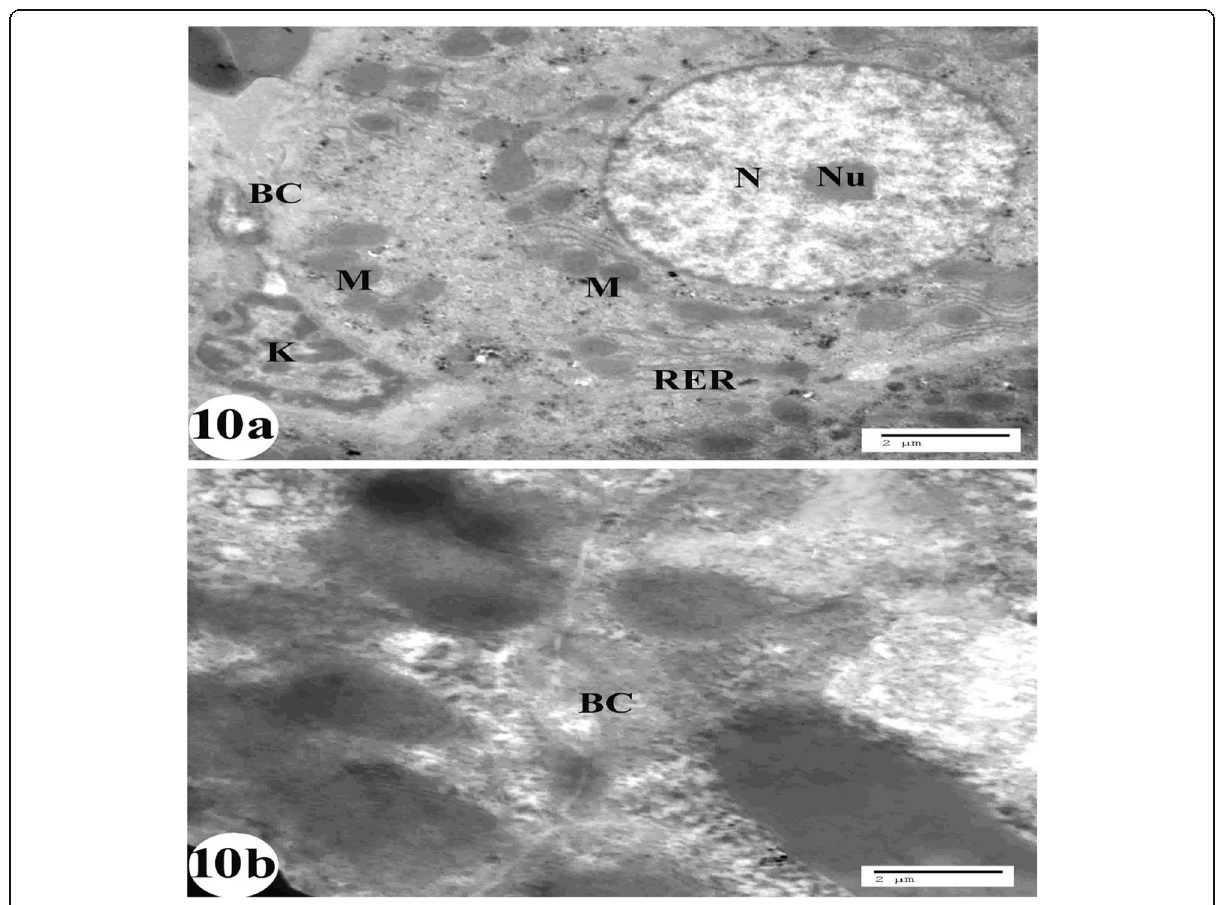
Fig. 10 Electron micrographs of a sections of liver of a control rats a showing hepatocytes contains numerous mitochondria (M), rough endoplasmic reticulum (RER) consists of closely pack parallel and flattened cisternae, spherical nucleus (N) appears with a distinct nuclear envelope and prominent nucleoli (Nu), Kupffer cell (K) with normal nucleus and normal bile canaliculi (BC) (scale bar = 2 μ m). b Showing high magnification of normal bile canaliculi (BC) with normal structure of microvilli (scale bar = 2 μ